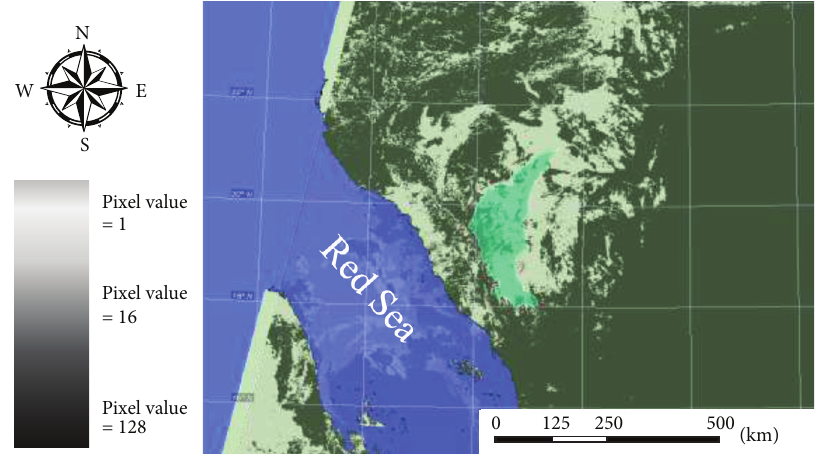
Figure 6: Cloud probability classification flags used with watershed